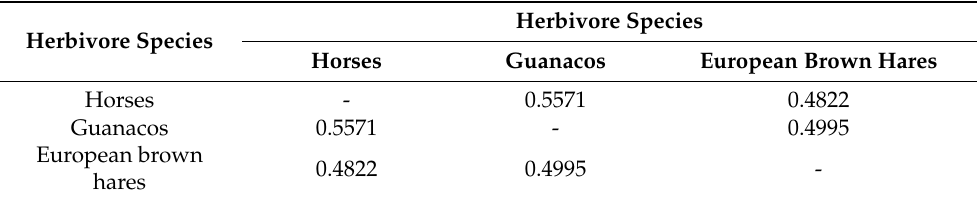
Table 2. Dietary overlap index between horses, guanacos, and European brown hares grazing on high mountain ranges of the Region of Coquimbo, Chile. Averages were obtained over two seasons. Herbivore Species Herbivore Species Horses Guanacos European Brown Hares Horses - 0.5571 0.4822 Guanacos 0.5571 - 0.4995 European brown 0.4822 0.4995 hares